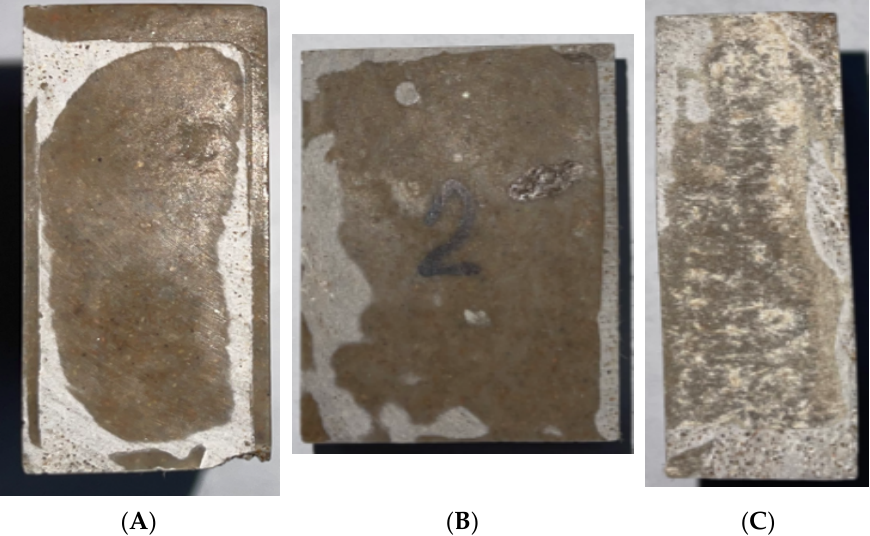
Figure 2. Sample No. 2 (polymer-concrete composition No. 23). ( A ) Top view; ( B ) Front (main) view; ( C ) Right side view. Table 1. Polymer-concrete composition No. 15.